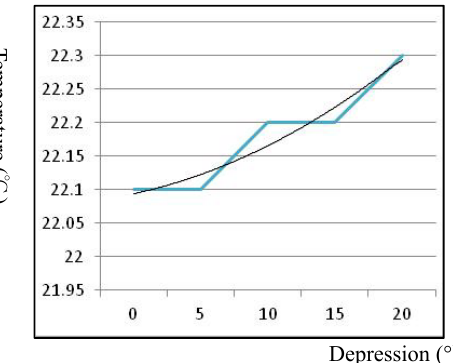
Figure 7. The graph of acrylic